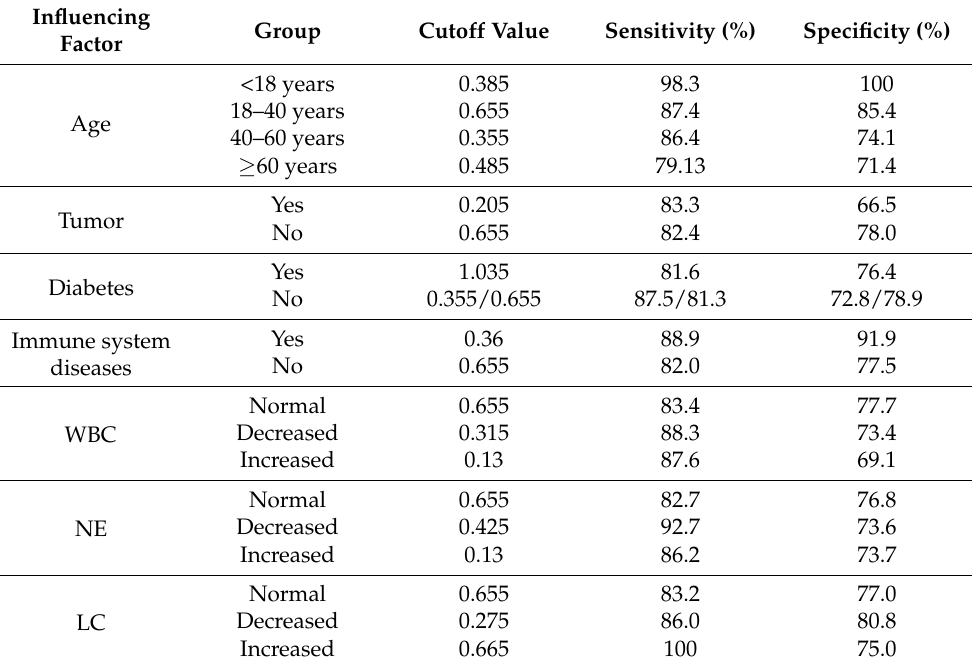
Table 6. Optimal cutoff values of QFT-GIT in the diagnosis of active tuberculosis in different influenc- ing conditions.